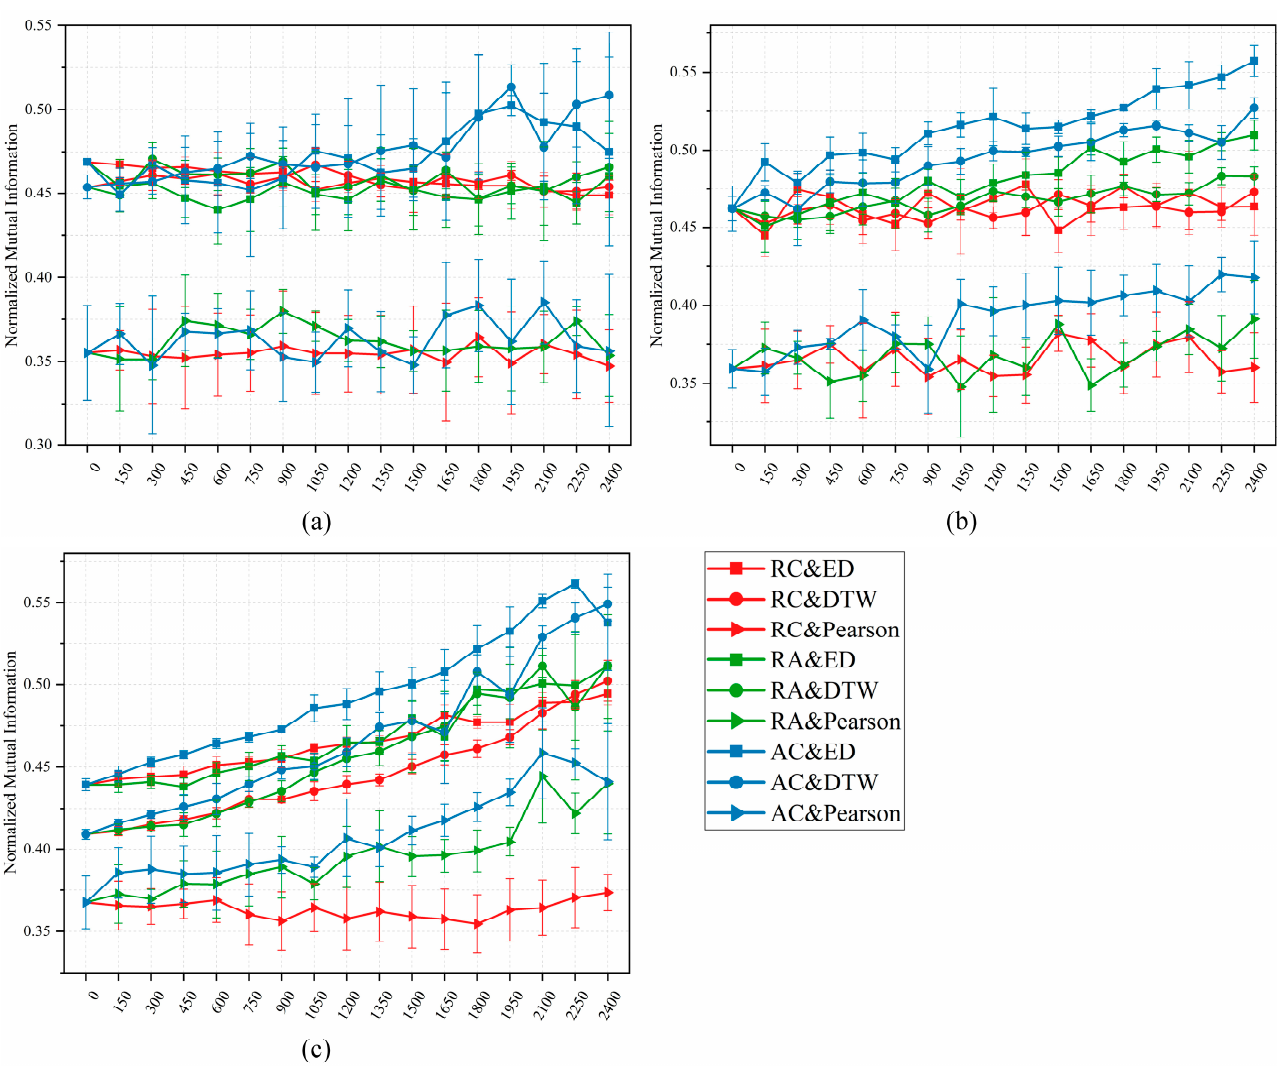
Figure 9. Performance plots show how the NMI increases with the number of pairwise constraints: ( a ) results of COP-KMeans; ( b ) results of PC-KMeans; ( c ) results of MIP-KMeans. The circular markers, the inverted triangular markers, and the square markers correspond to the results obtained using ED, DTW, and Pearson, respectively.